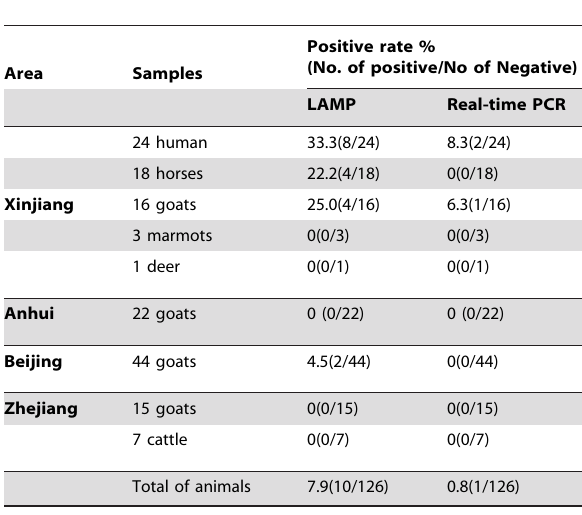
Table 3. Results of detection of clinical samples by the LAMP and real-time